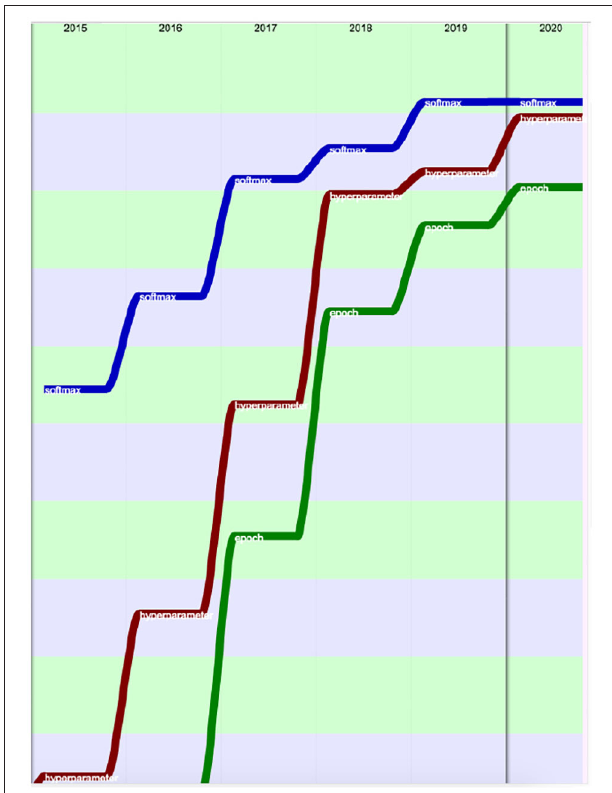
FIGURE 36 | Evolution of the terms “softmax” (blue), “hyperparameter” (red) and “epoch” (green) over the past 5 years (from the 100th rank in 2015 to the 20th in 2020), according to their